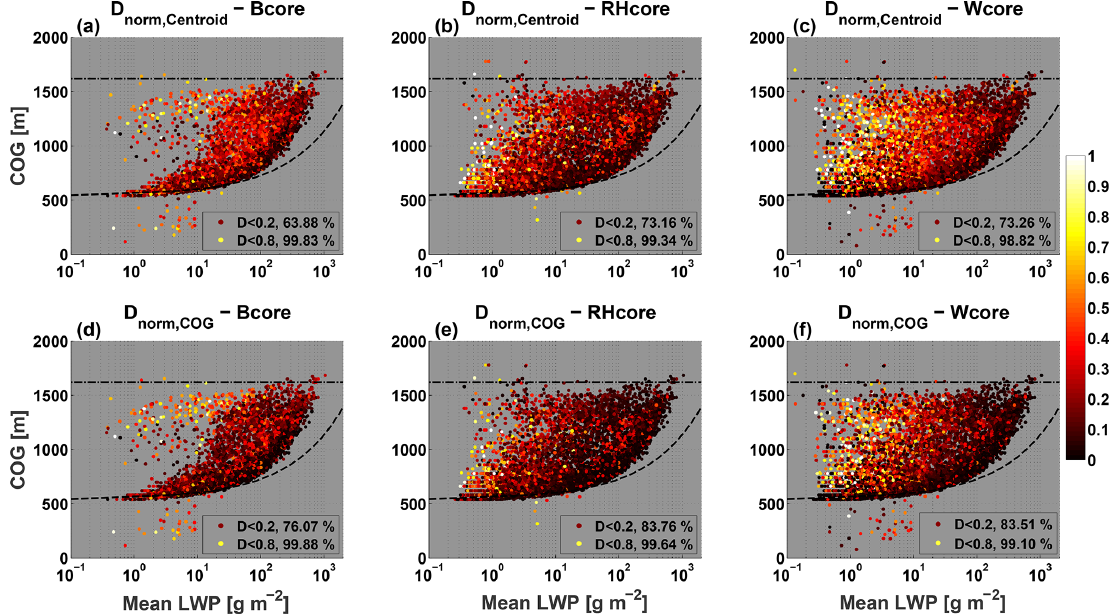
Figure 7. CvM phase-space diagrams of distances between core centroid and cloud centroid ( D norm , centroid ; a, b, c ), and distances between core COG and cloud COG ( D norm , COG ; d, e, f ) location, for the three different physical core types. The distances are normalized by the maximum distance between the cloud centroid or COG and the cloud perimeter. Bright (dark) colors indicates large (small) distances. Legends include percentage of points (out of the scatter) with D norm below a certain threshold. As seen in Fig. 5, only clouds which contain a core fraction above zero (for the core in question) are